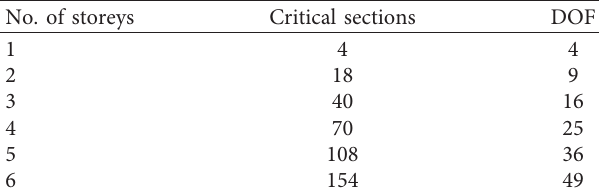
Table 5: Characteristics of